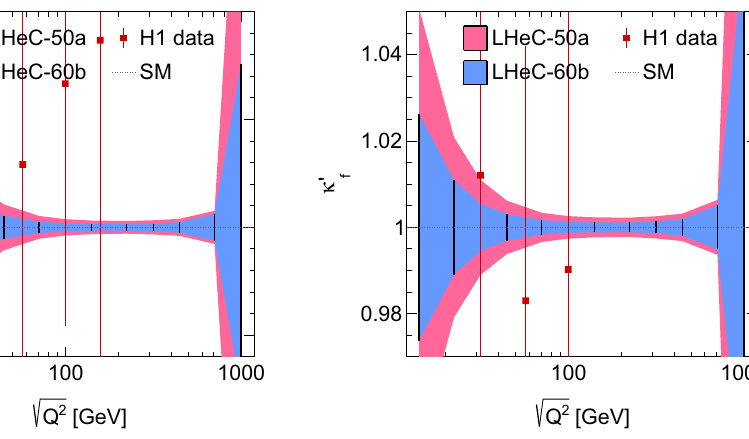
(μ 2 ) the region of about Q 2 ≈ 20 , 000GeV 2 for scenario LHeC-60b. NC , f The expected uncertainties are compared to measured values by H1 [18]